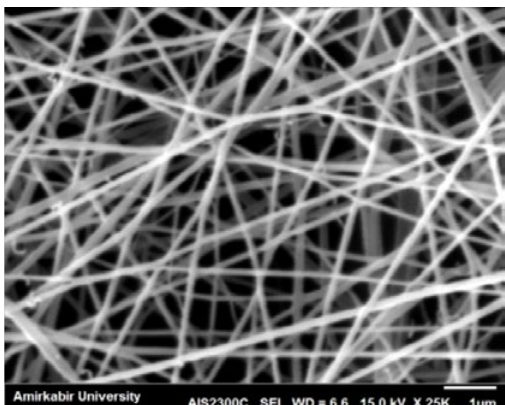
Fig.2. SEM image of electrospun CS/PEO nanofiber with 0.4 g Fig.2 SEM image of electrospun CS/PEO nanofiber with 0.4 g vancomycin